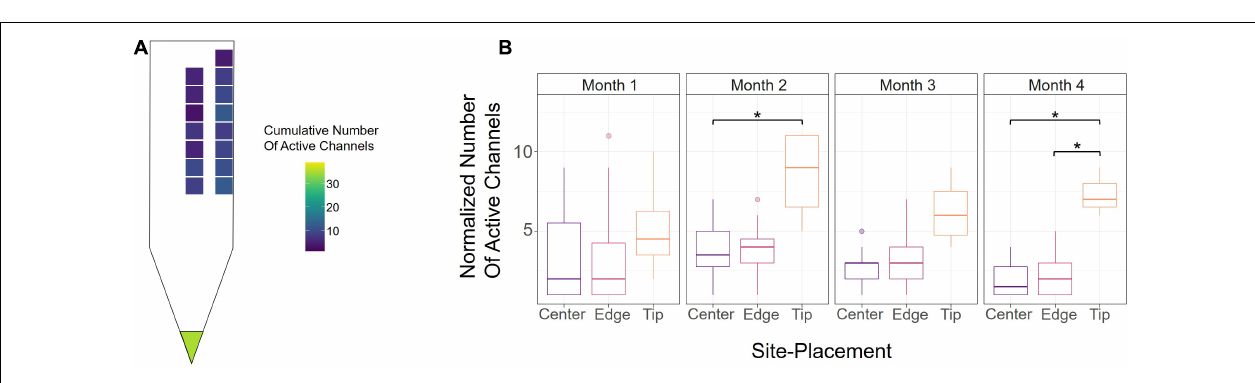
FIGURE 3 | Active channels over time. (A) Heatmap of the average cumulative number of active channels for each site over the 16-week period across all six animals. An electrode-site was considered active if it could elicit a behavioral response below 30 nC/Phase during an experimental session. (B) Number of active center, edge, and tip channels for each month across all six animals, normalized by number of sites. * p ≤